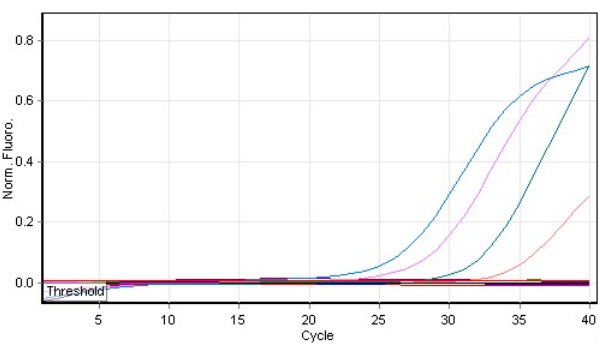
Figure 5 qPCR amplification of Botrytis cinerea in some tested lettuce leaves. Sample colors: see Table 2.